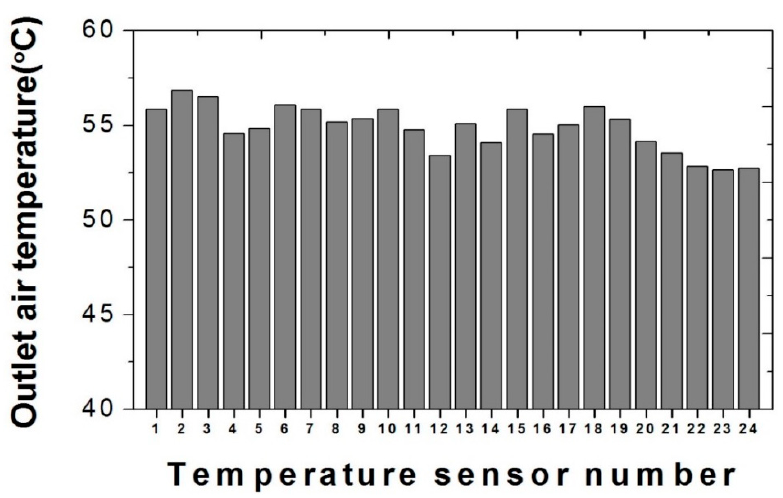
Figure 11. Experiment result of outlet air temperature distribution according to the heat dissipation location of the heater (inlet mass flow rate 300 kg/h).